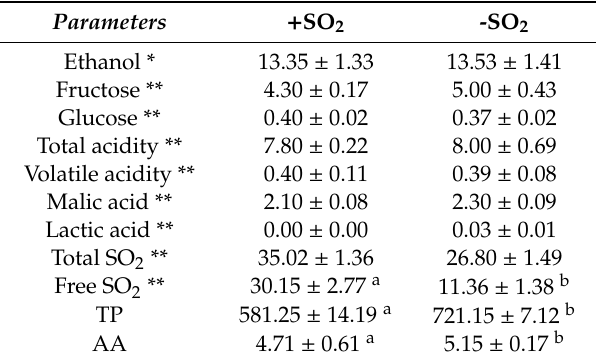
Table 3. Main oenological parameters in wines obtained with the mixed starter ND-SA at pilot-scale vinifications with ( + SO 2 ) and without SO 2 addition (-SO 2 ). For each compound, superscript letters mean significant di ff erences at p ≤ 0.05 among wines produced in the two di ff erent conditions. Data are expressed as mean value ± SD of two independent